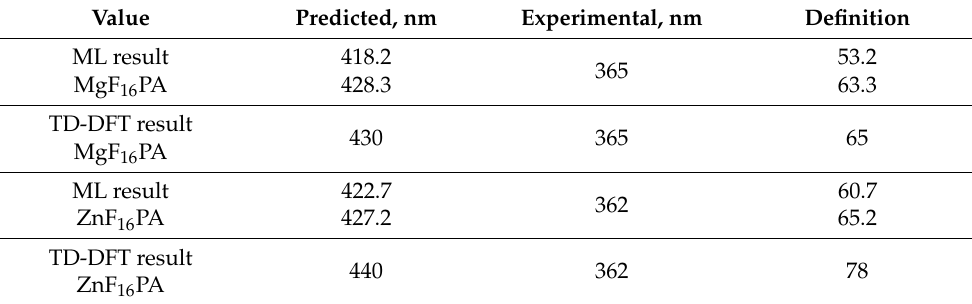
Table 5. The comparison of Soret band predictions by ML and